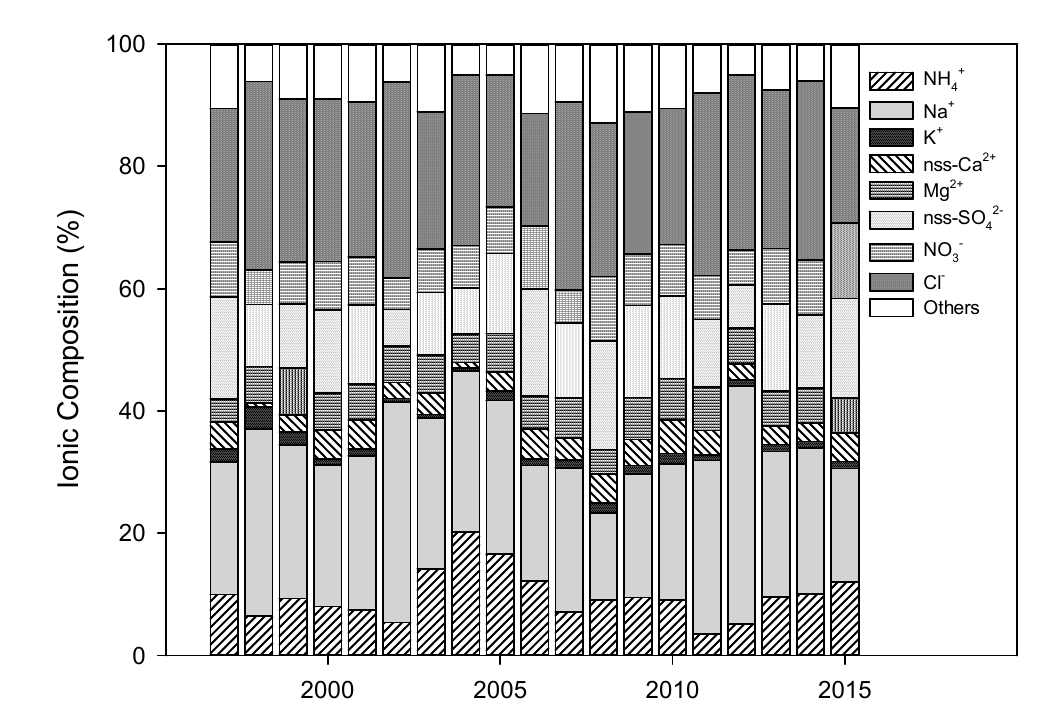
Figure 6. Long-term variations in the ionic composition of precipitation between 1997 and 2015.